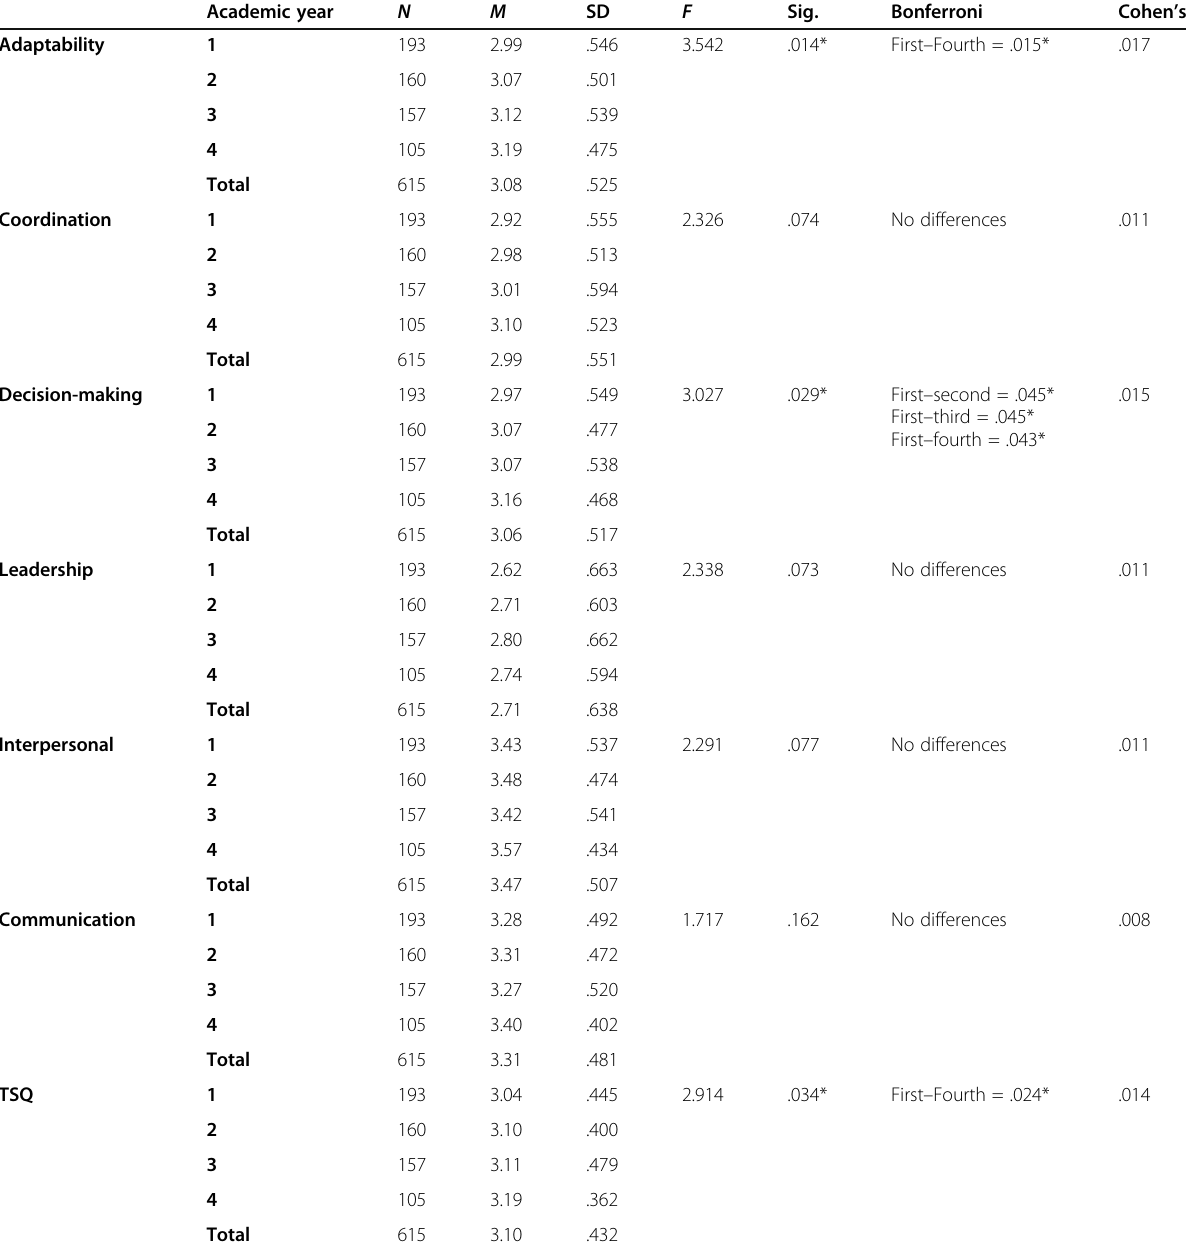
Table 4 ANOVA results based on academic year Academic year